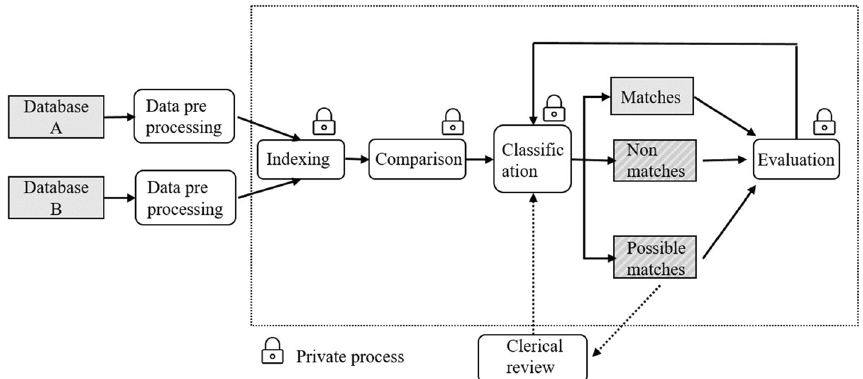
Fig. 2 Outline of the general privacy-preserving record linkage process adopted from